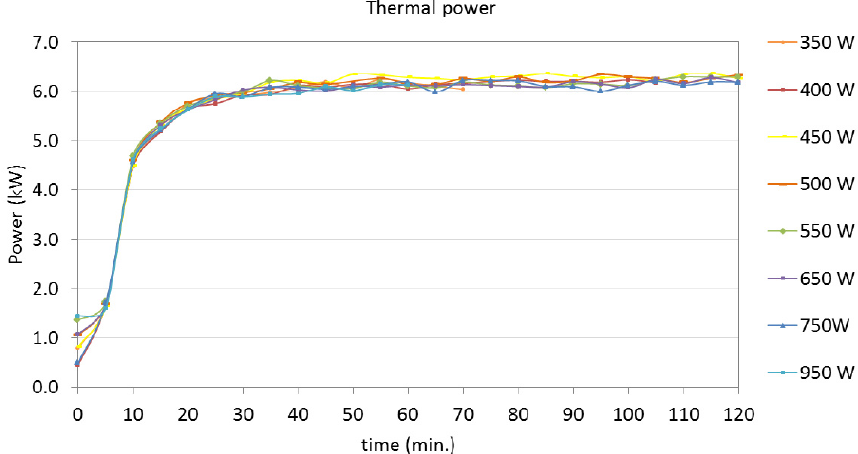
Figure 4. Heat rate as a function of time for the different tests in kW.